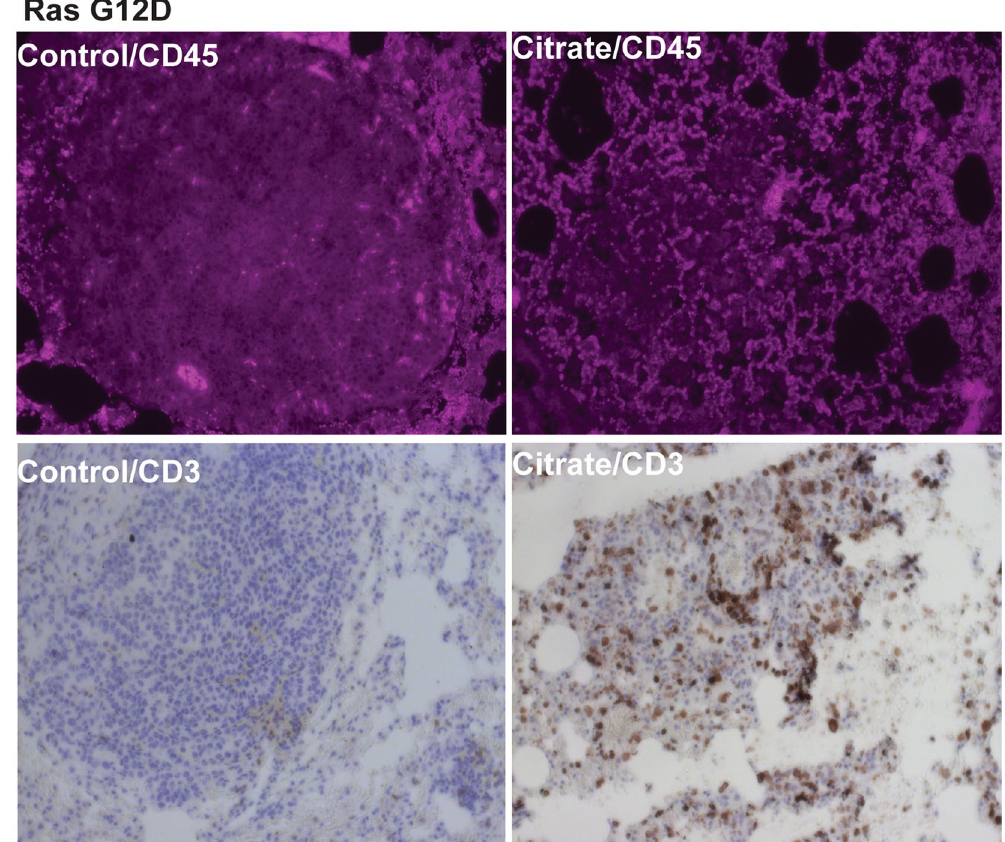
Figure 3. Citrate treatment promotes T-cells infiltration to lung and breast tumor. Ras driven mice with lung tumor were treated with 4 g/kg citrate twice daily for 4 weeks and samples were collected and stained with anti-CD45 and CD3